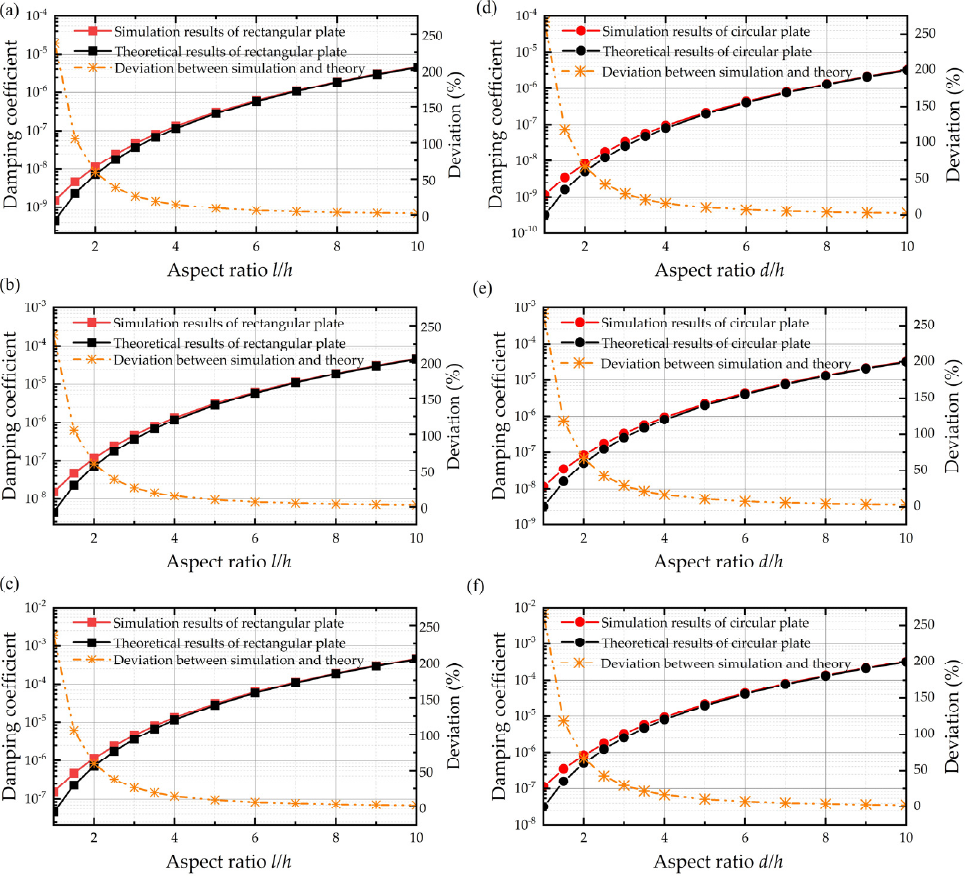
Figure 4. Damping coefficient of simulation results, theoretical results, and the deviations between them. ( a – c ) Rectangular plate when the air film thickness is 0.06 mm, 0.6 mm, and 6 mm from top to the bottom. ( d – f ) Circular plate when the air film thickness is 0.06 mm, 0.6 mm, and 6 mm from top to the bottom.